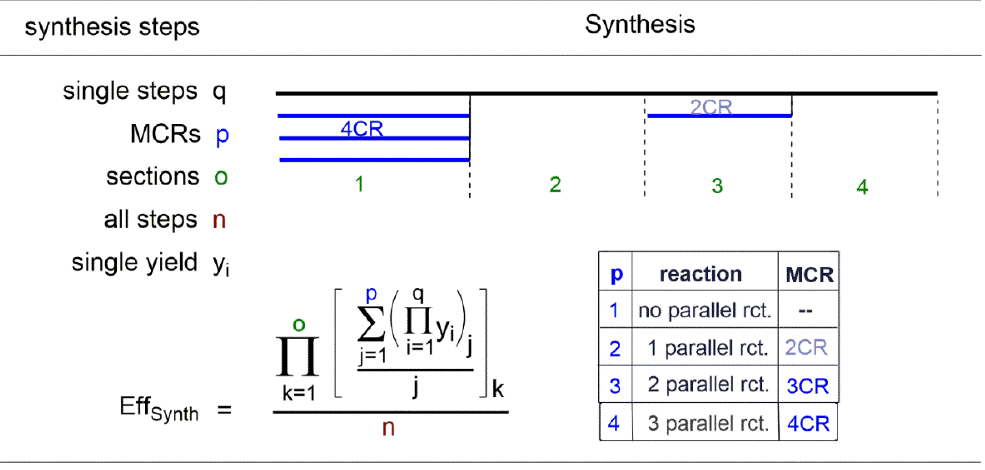
Figure 6. Algorithm “Sythesis efficiencies including MCRs” phrased as mathematical equation.